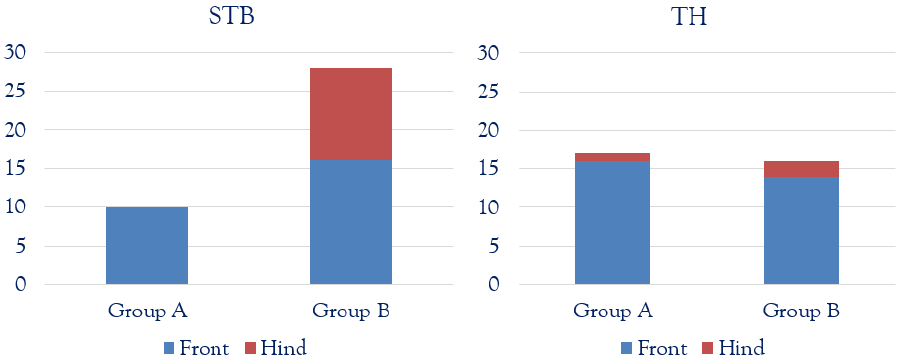
Figure 3. Study population for standardbreds (STBs) and thoroughbreds (THs), in both Group A (2–4 years old) and Group B (>5 years old). Front fetlocks are represented in the blue columns and hind fetlocks in the red ones. Tables 2 and 3 report cartilage thickness results for STBs and THs, respectively. Table 2. Cartilage thickness results reported in millimetres, for standardbreds (STBs), in Group A (A) and Group B (B).